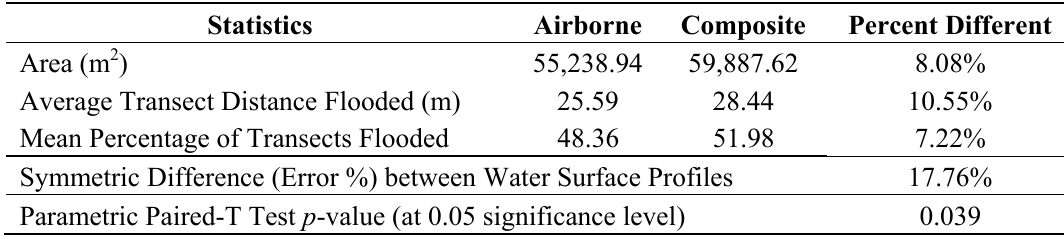
Table 5. Quantitative comparison of parameters between the water surface profiles generated using the bare-earth airborne and composite LiDAR